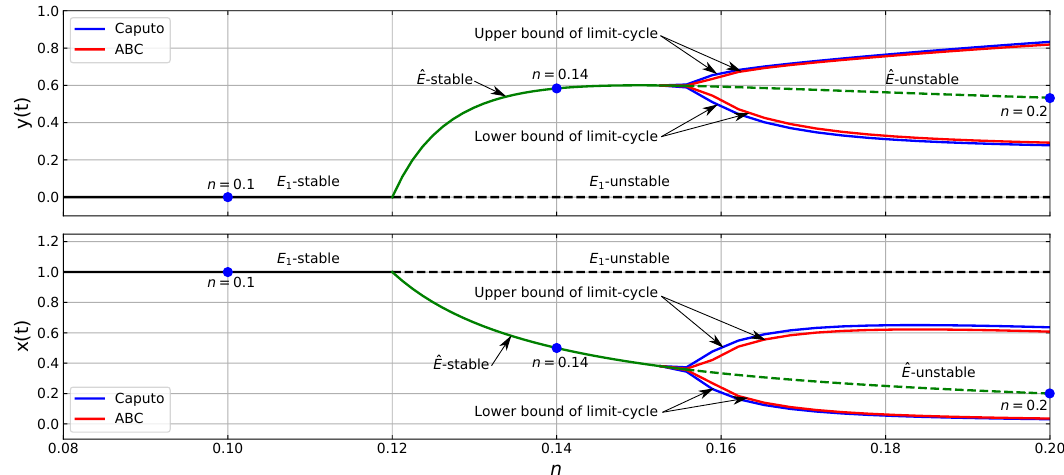
Figure 1. Bifurcation diagram of Caputo model (6) and ABC model (16) driven by the conversion rate of consumed prey into predator birth ( n ) with constant parameter values (29). There exists two bifurcations namely a forward bifurcation which occurs when n passes through n ∗ bifurcation which occurs when n passes through n ∗